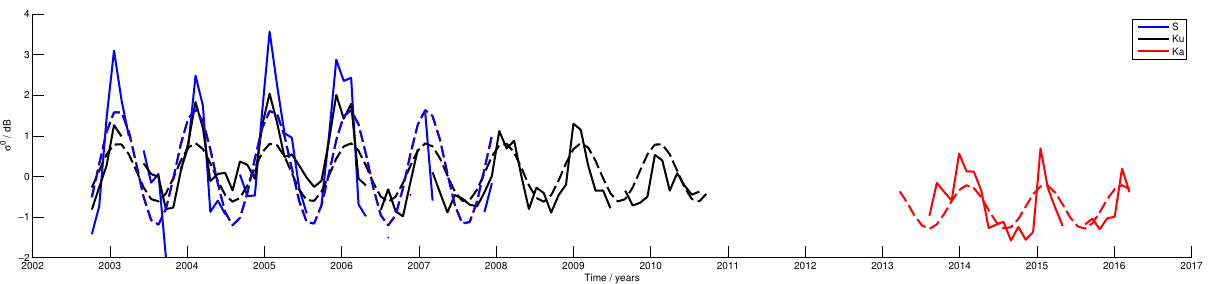
Figure 1. Time series of the backscattering coefficient at the S (blue), Ku (black) and Ka (red) bands at location (69.468 ◦ S, 134.28 ◦ E) between October 2002 and December 2007 at S band, October 2002 and September 2010 at Ku band and March 2013 and March 2016 at Ka band. The dashed lines represent the best fits to the time series (see Eq. 1). The observations show the seasonal cycle with a 1-year period at the different